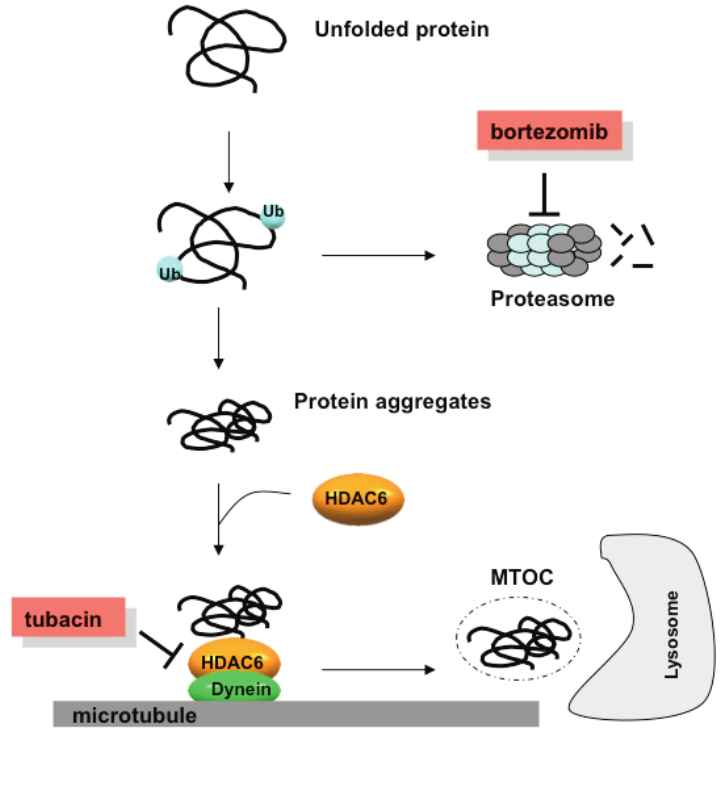
Figure 2. The aggresome pathway prevents accumulation of misfolded proteins. Unfolded or misfolded proteins, that exceed proteasomal degradation, form aggregates and are transported to the microtubule organizing center (MTOC) for degradation. This trans- port requires HDAC6 which deacetylates alfa-tubulin and binds both polyubiquitinated proteins and dynein. Inhibiting HDAC6 with tubacin, whether or not combined with the proteasome inhibitor bortezomib, accumulates misfolded or unfolded proteins and leads to